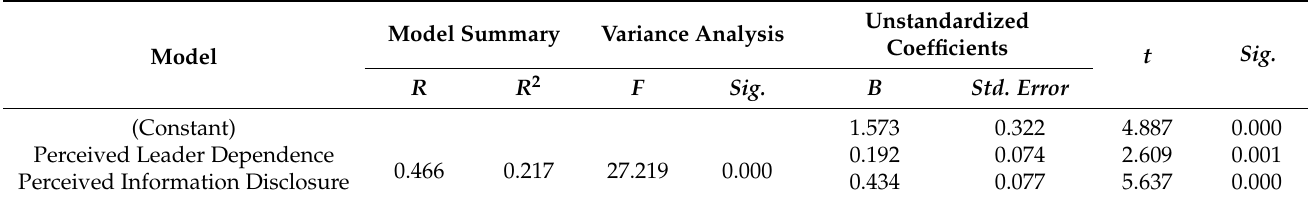
Table 17. Regression Analysis of Perceived Leadership Trust on Influence.